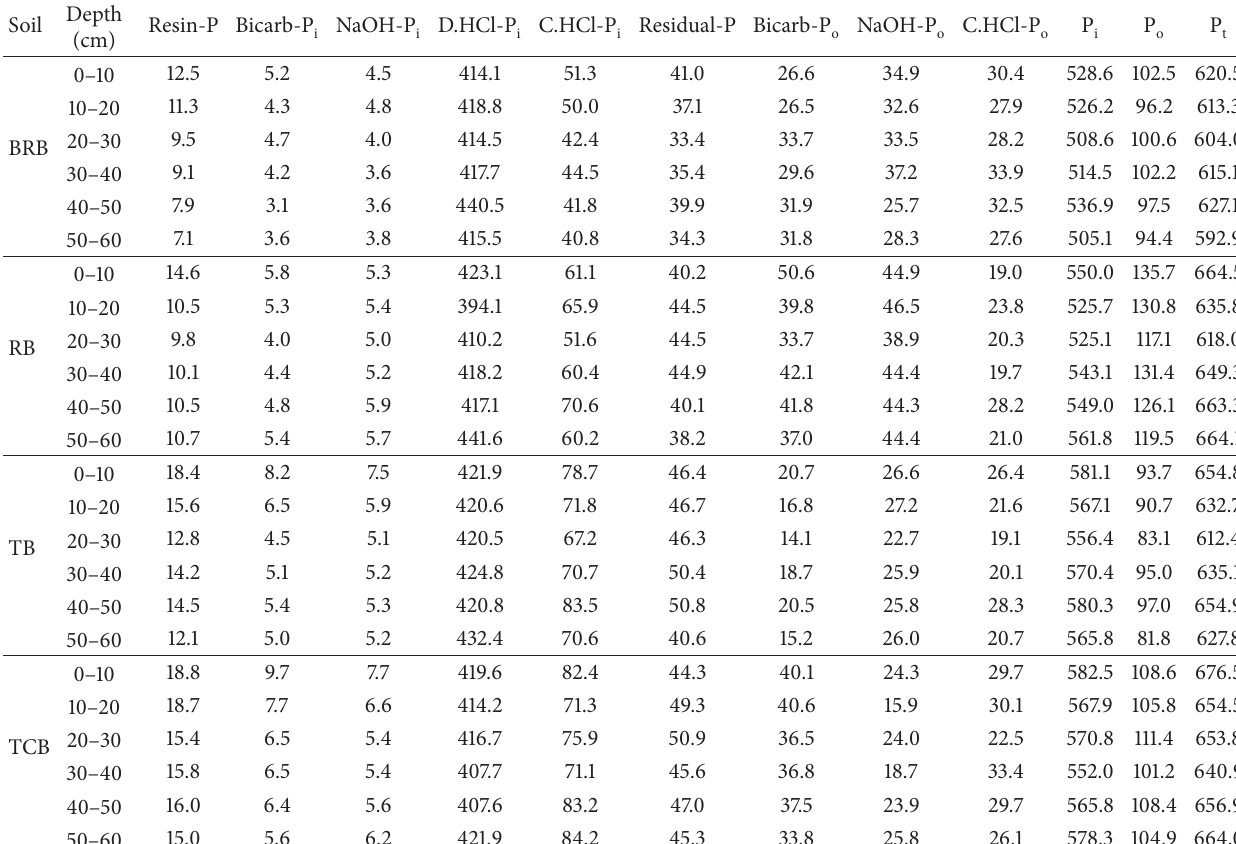
Table 3: Mean content (mgkg − 1 ) of P forms of the tidal river network region soil profiles in the Yellow River Delta estuary. Depth Soil